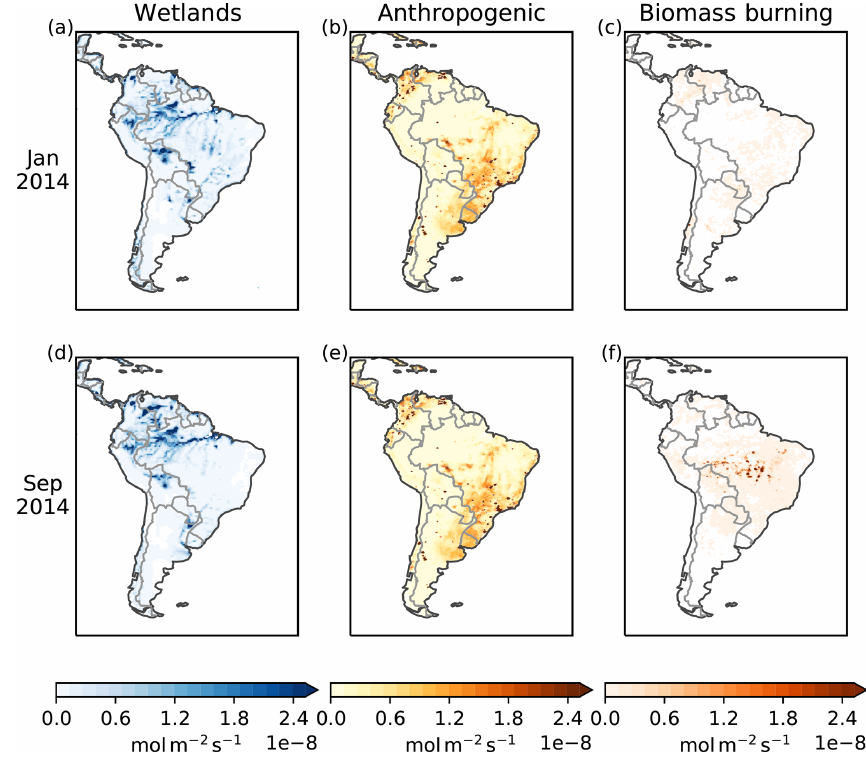
Figure 2. A priori emissions for wetlands, anthropogenic and biomass burning sectors for January and September 2014. These months are representative of peak wetland extent in the wet season (January) and biomass burning activity (September). Note that the EDGAR anthropogenic inventory is annual resolution and is shown here for 2012. Table 1. Summary of a priori emissions and boundary conditions used in this study. All maps have been regridded to 0.23 ◦ latitude by 0.35 ◦ longitude